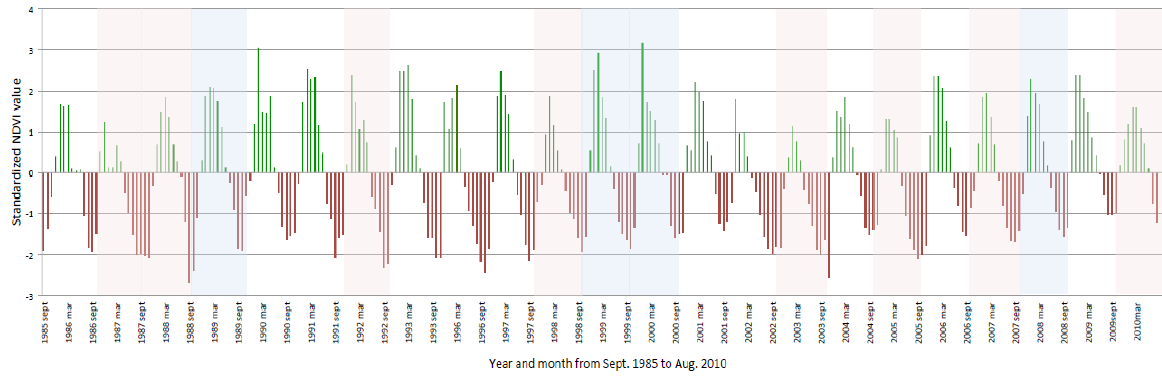
Figure 2. Standardized monthly maximum value composites (MVC) NDVI values for Chobe River Basin from 1985 to 2010 where green bars indicate positive departures, while red bars indicate negative ones; 1994 and 1995 missing due to sensor outage. The pink shading indicates warm ENSO phase years, while the blue shading indicates cold phase ENSO events (based on ENSO data extracted from